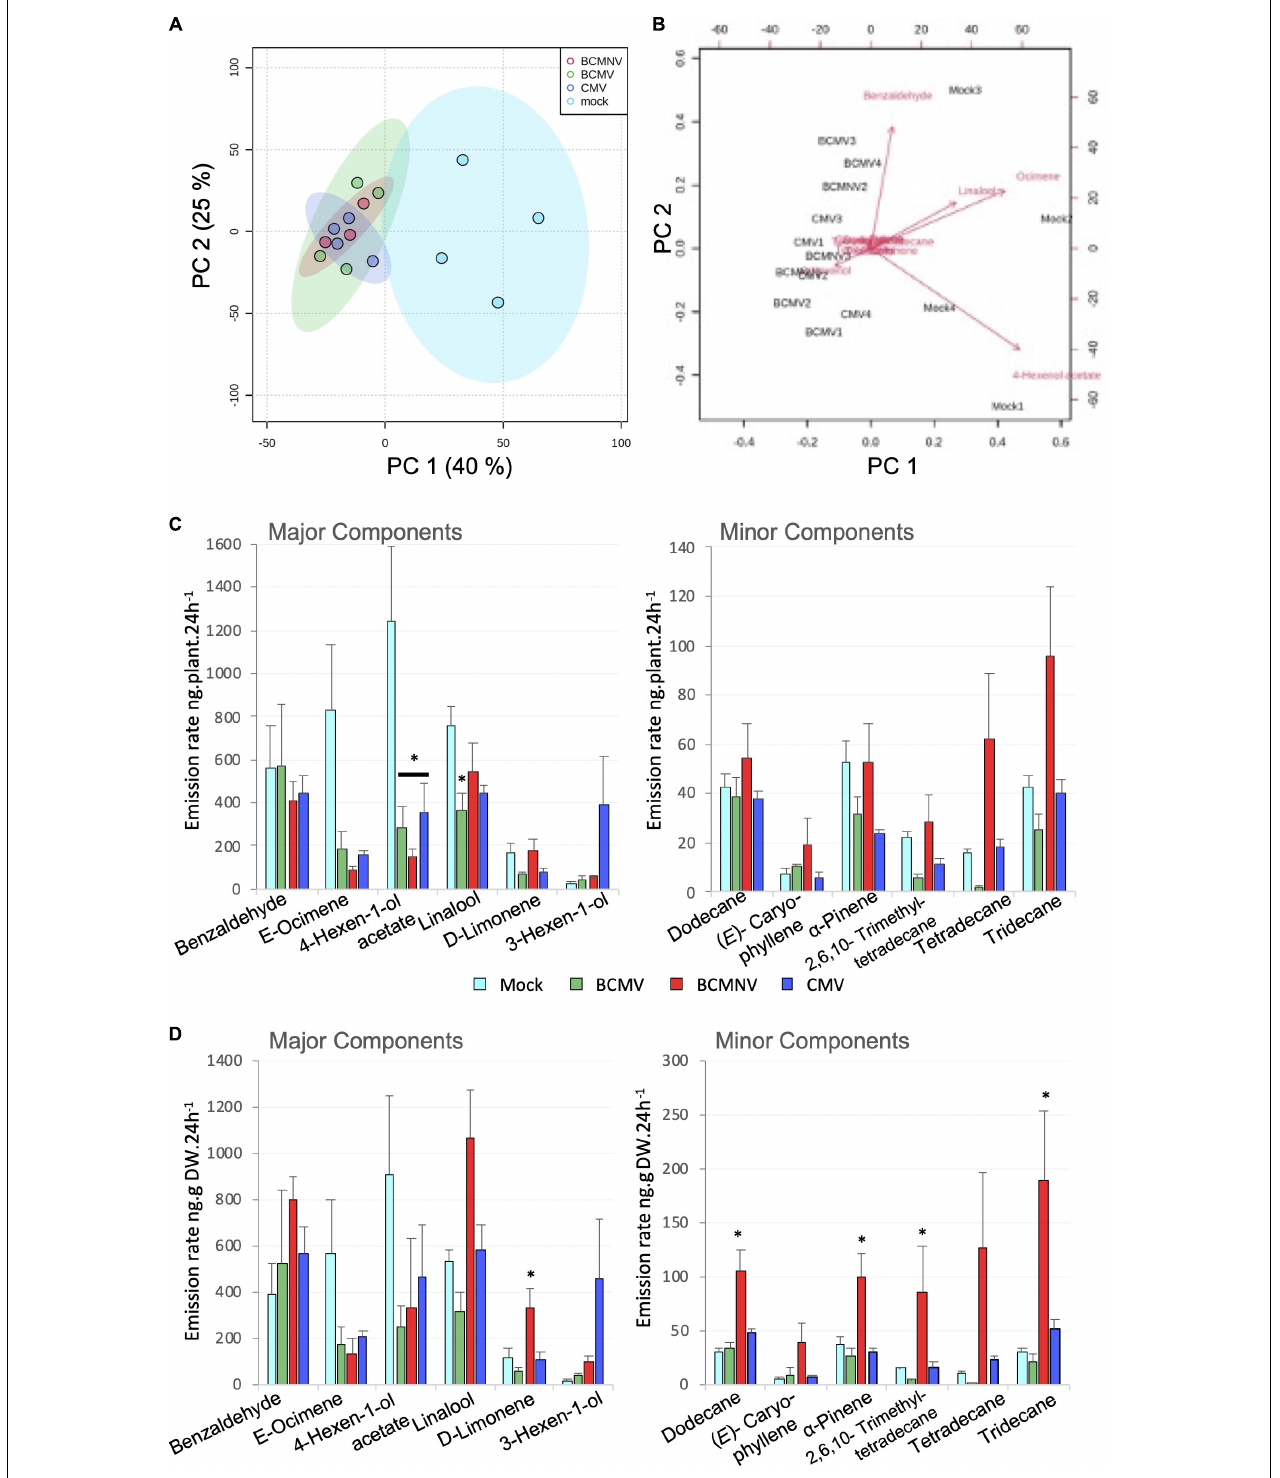
FIGURE 2 | Blend of volatile organic compounds (VOCs) emitted by flowering bean plants infected with different viruses. (A) Score scatter plot from principal component (PC) analysis of quantified VOCs collected by dynamic headspace trapping from bean plants that had been mock-inoculated (light blue), infected with BCMV (green), BCMNV (red) or CMV (dark blue). The percentage of variation of the data explained by PC1 and PC2 is in parentheses (40.1 and 25%, respectively). (B) PCA plot with loadings (biplot) to illustrate the variables that have the largest effect on each sample. The longer the vector, the more influence the variable has